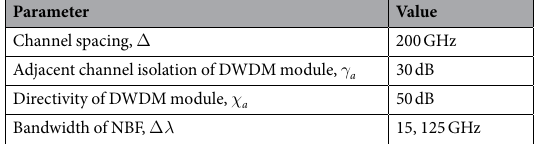
Table 2. Nominal values used for the DWDM system parameters.